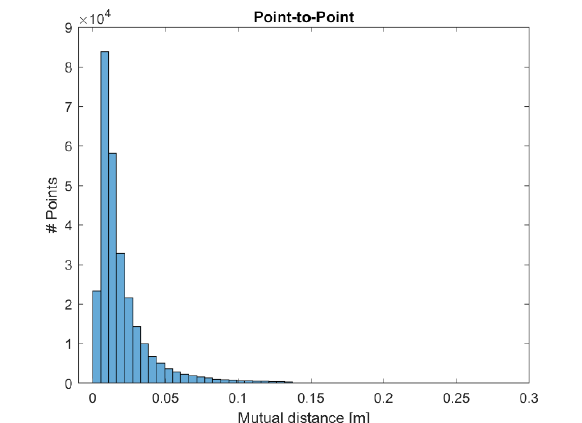
Figure 14. Distance histogram for point-to-point